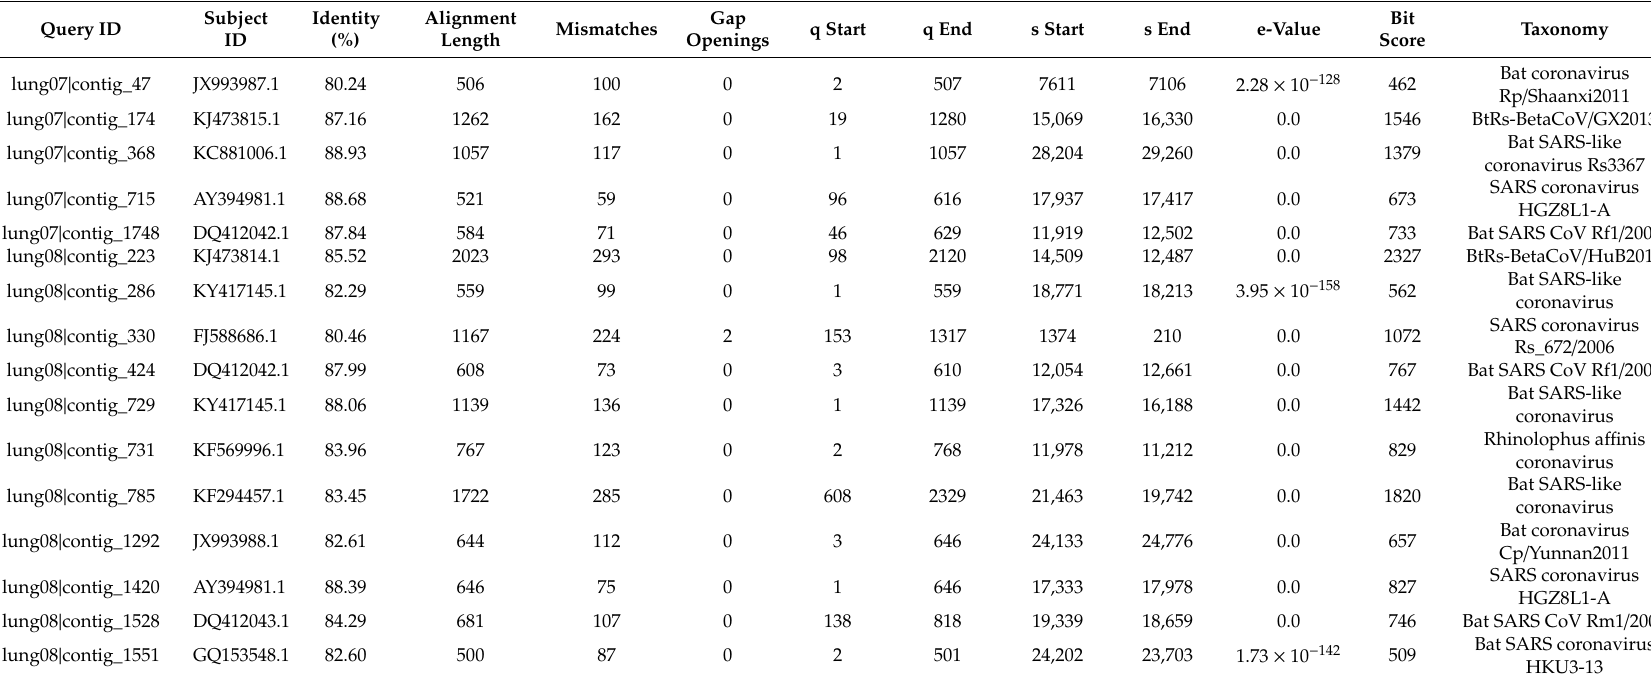
Table 3. Information of contigs with a high level of sequence similarity and then confirmed as Coronavirinae. See table legend of Table S2 for a detailed explanation of the table